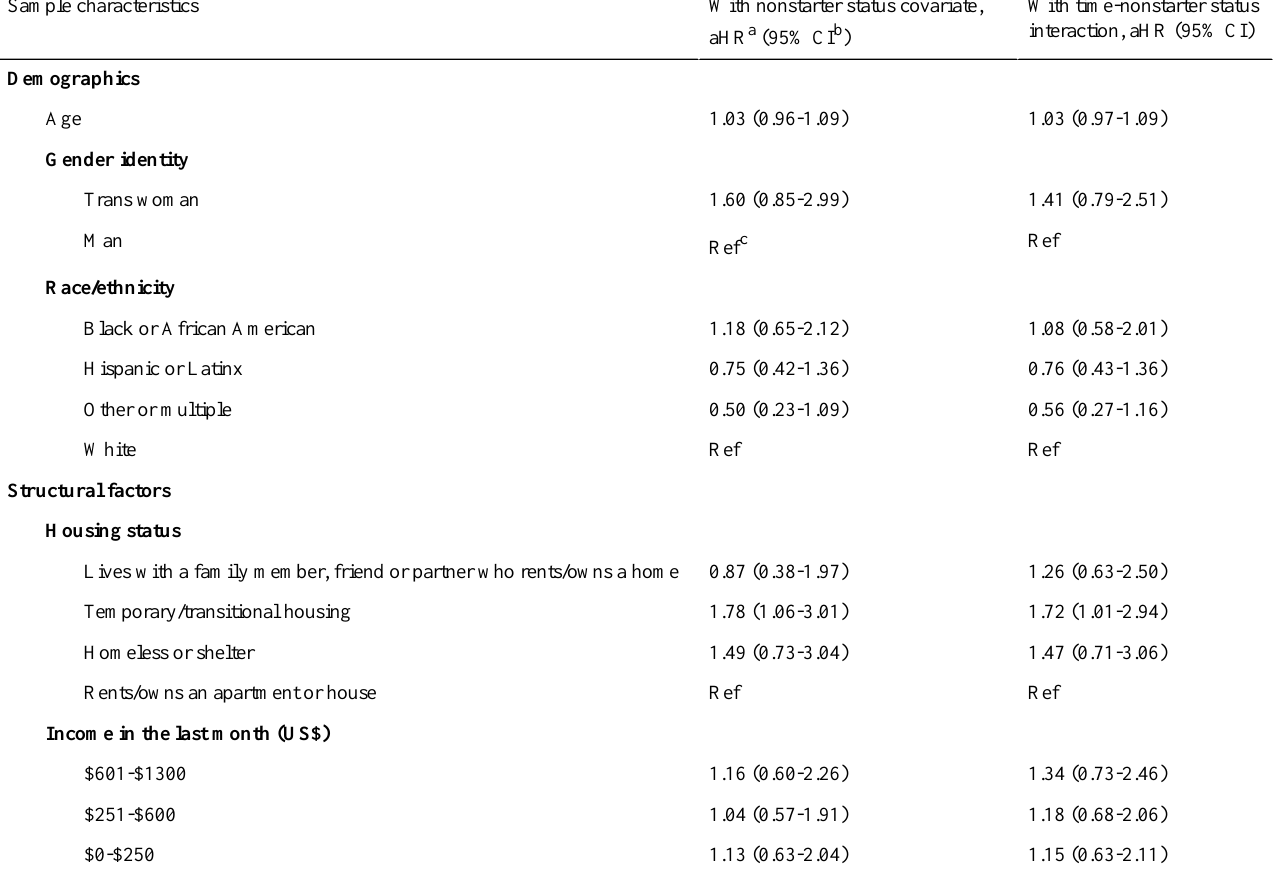
Table 2. Sample characteristics in relation to Cox proportional hazards of weeklong or more ecological momentary assessment survey noncompletion from the 2017-2018 Health eNav study